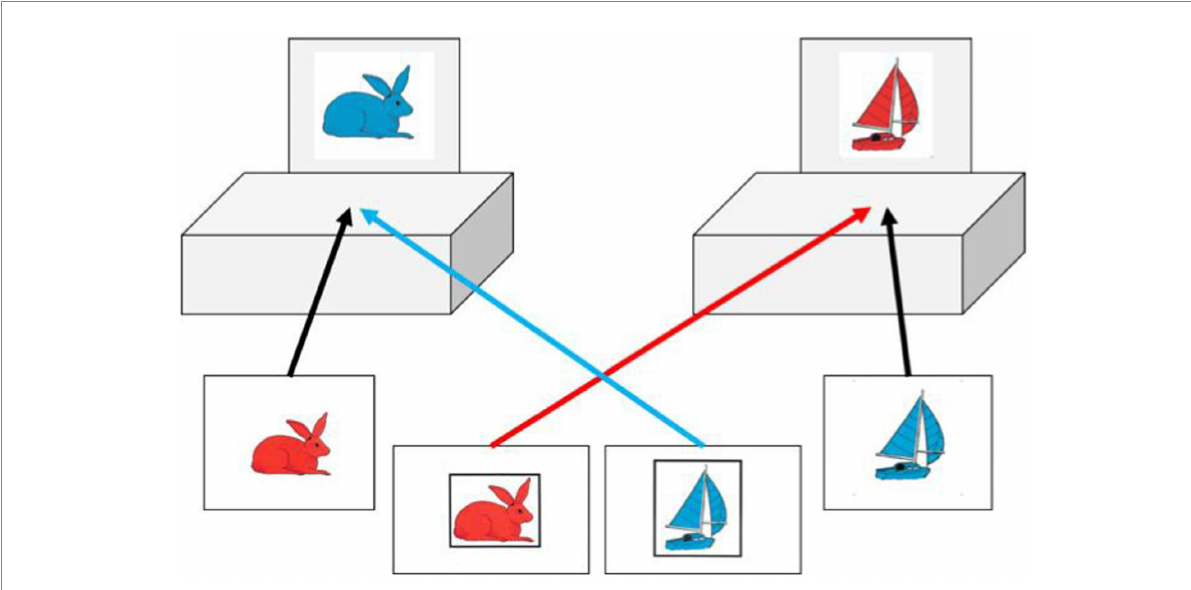
FIGURE 2 Schematic illustration of the DCCS Phase 3 of border version inspired by Chevalier and Blaye (2006) and Blaye (2021). Notes: Figure Black arrows correspond to a correct sort for the “shape set” while colored arrows correspond to a correct sort for the “color set” (cards with a black